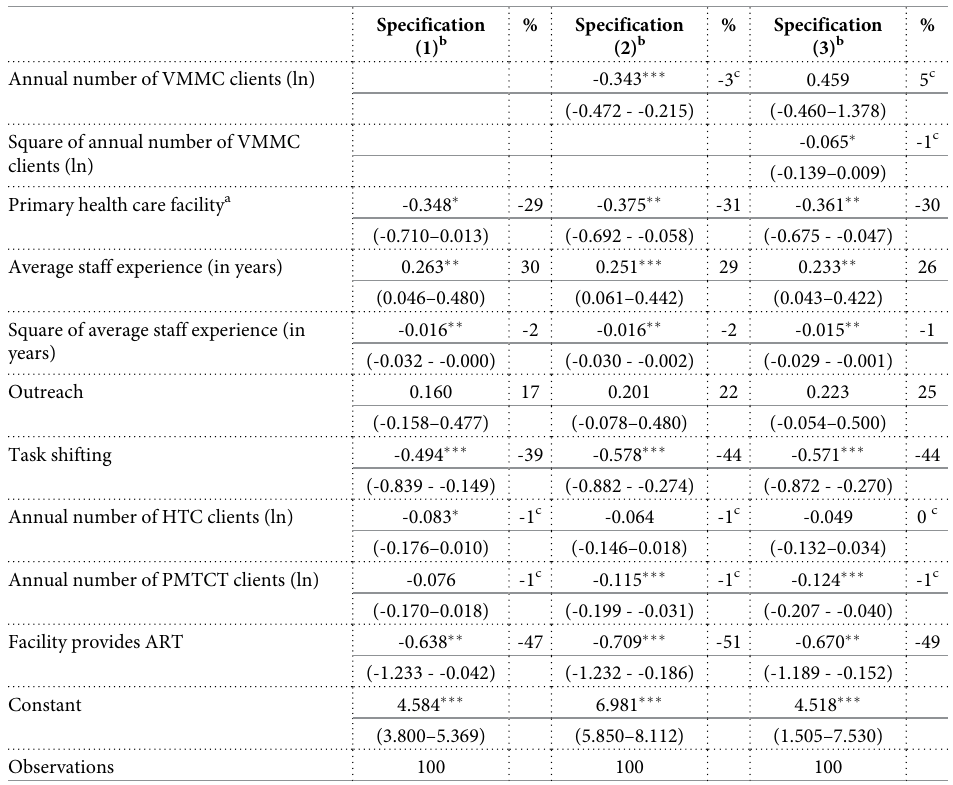
Table 3. GLM regression models. Dependent variable is the natural logarithm of the facility-level average cost per VMMC (unit